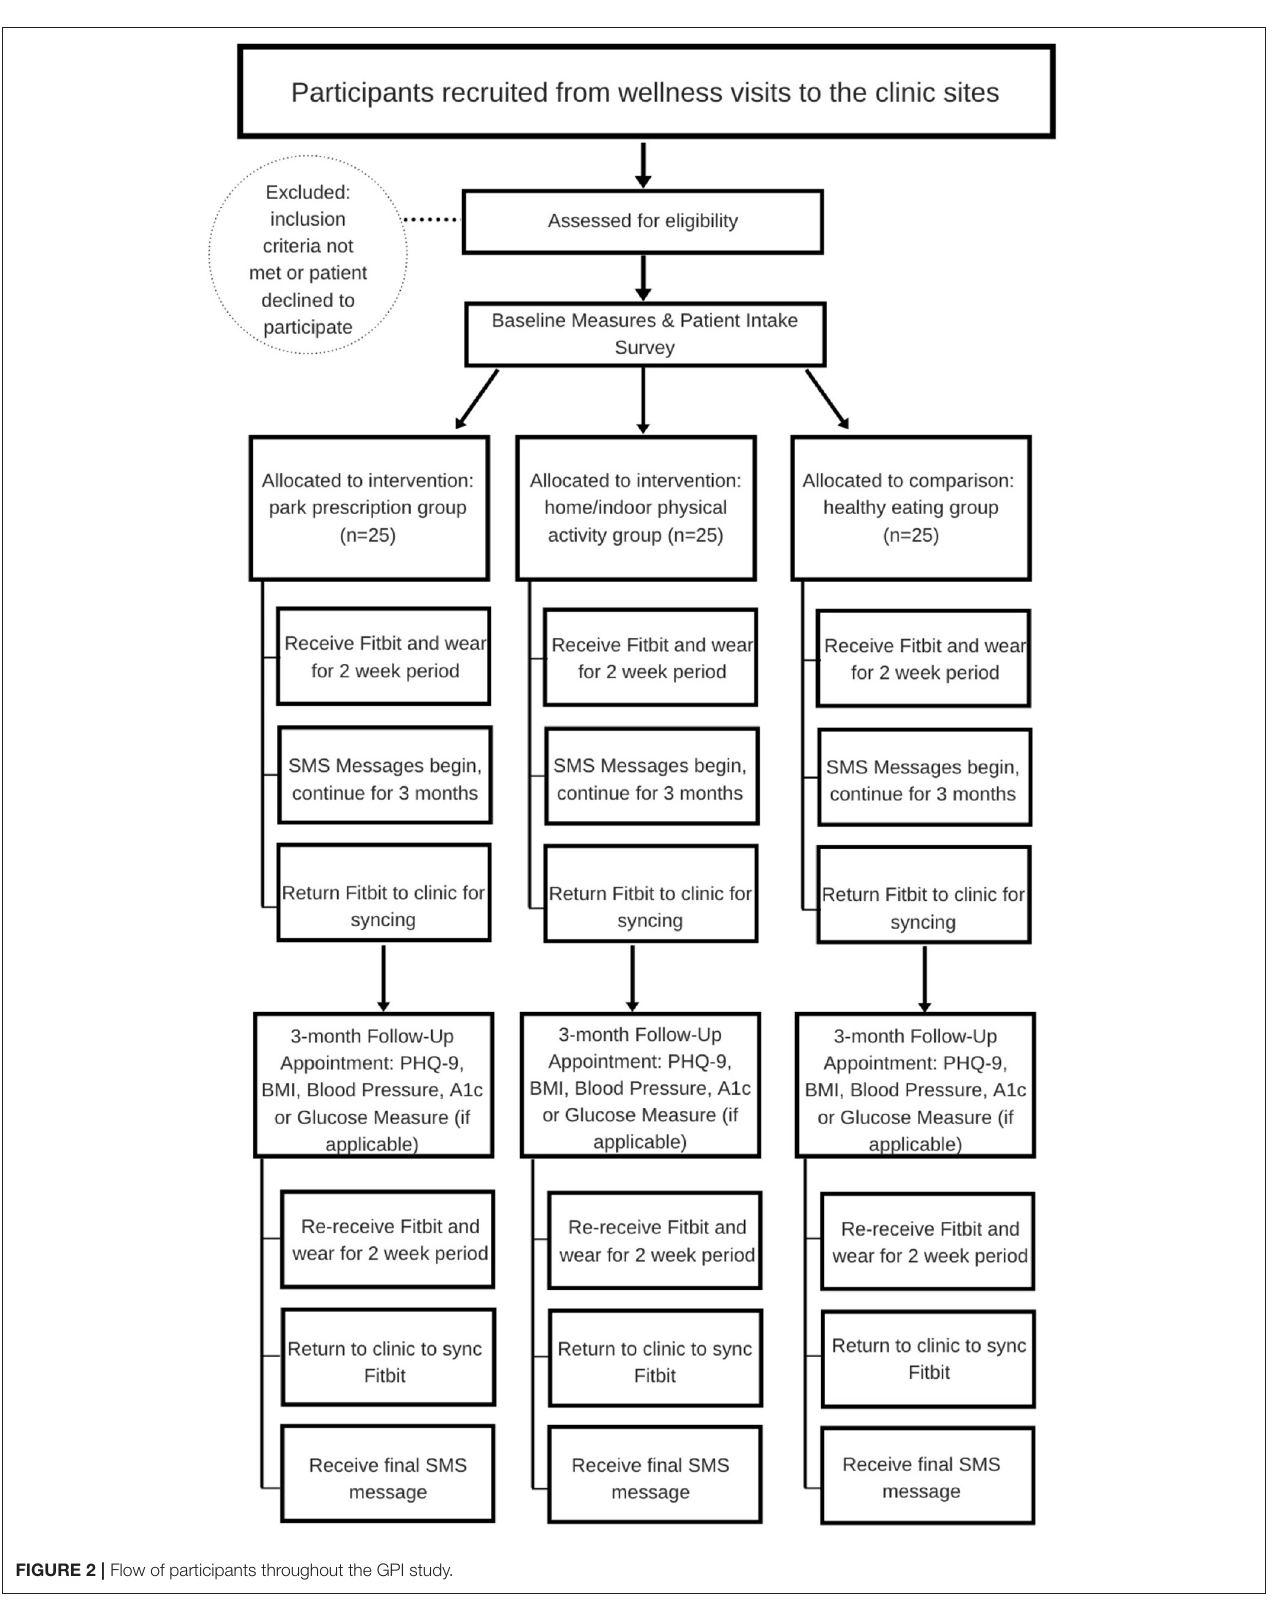
FIGURE 2 | Flow of participants throughout the GPI